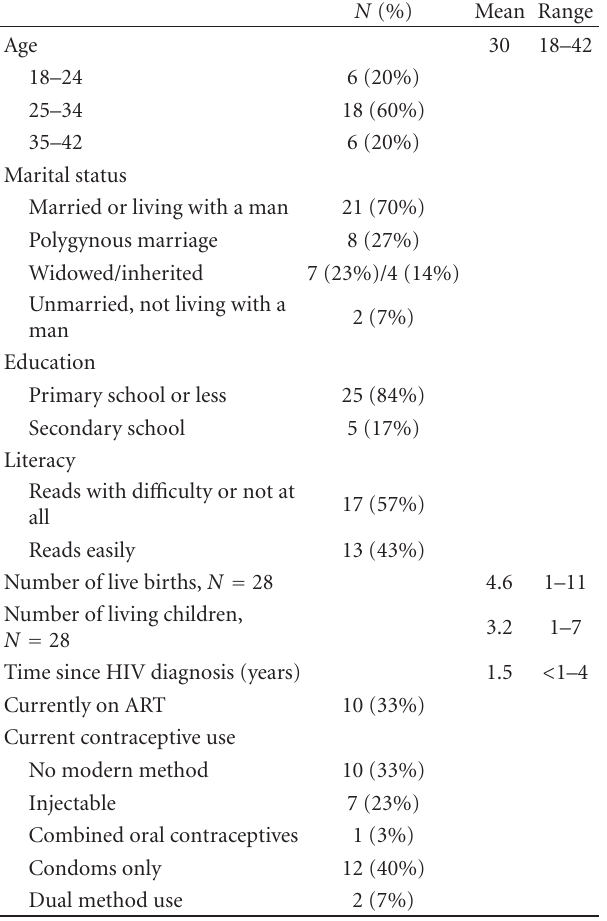
Table 1: Participant sociodemographic characteristics and current contraceptive use among 30 study participants in Nyanza Province,